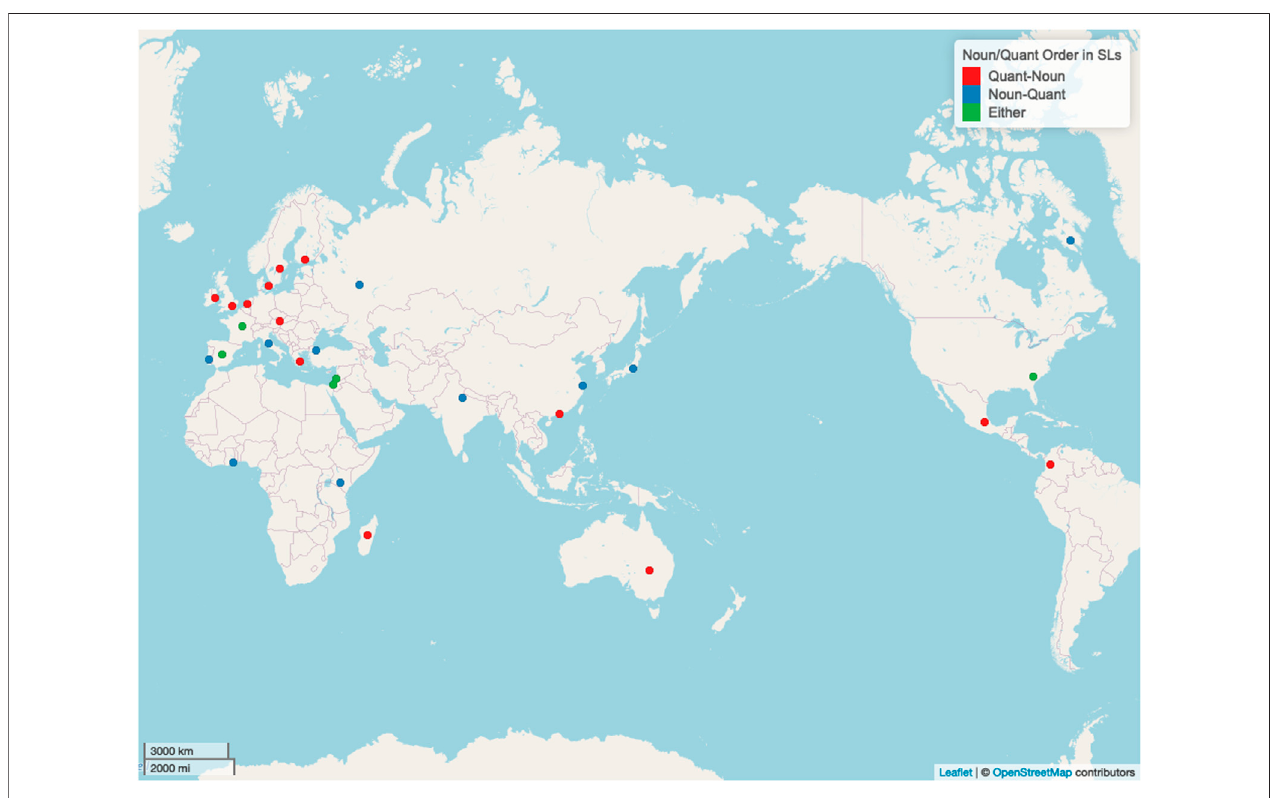
FIGURE 5 | Map of noun/quanti fi er order in sign languages.